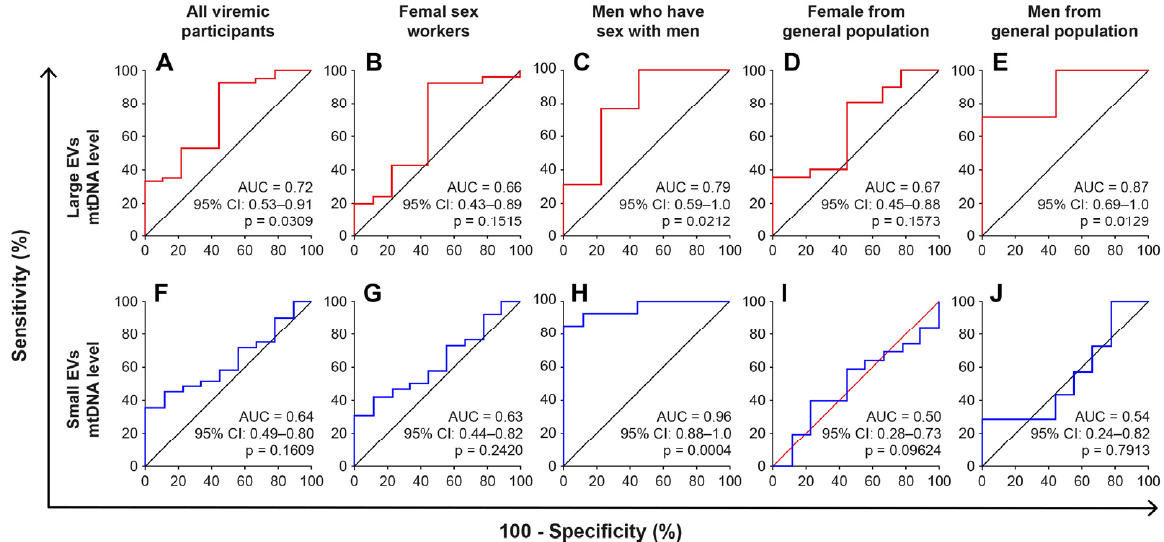
Figure 7. Performance of the mtDNA content of large and small EVs as a discriminator of viremic HIV+ patients, based on receiver operating characteristic curve analysis. Large and small EVs mtDNA level was used to generate a Receiver Operator Characteristic (ROC) curve analysis to discriminate viremic participants. Participants with <500 CD8 T cells/ µ L, ≥ 500 CD4 T cells/ µ L, and CD4/CD8 ratio ≥ 1 (group 1, n = 10) were used as controls. Diagnosis performance of large EVs and small EV-mtDNA level for the discrimination of all viremic participants ( A , F ), viremic female sex workers ( B , G ), viremic men who have sex with men ( C , H ), and viremic women ( D , I ) and men ( E , J ) from the general population respectively. The Wilson/Brown method was used to compute the area under the curve.